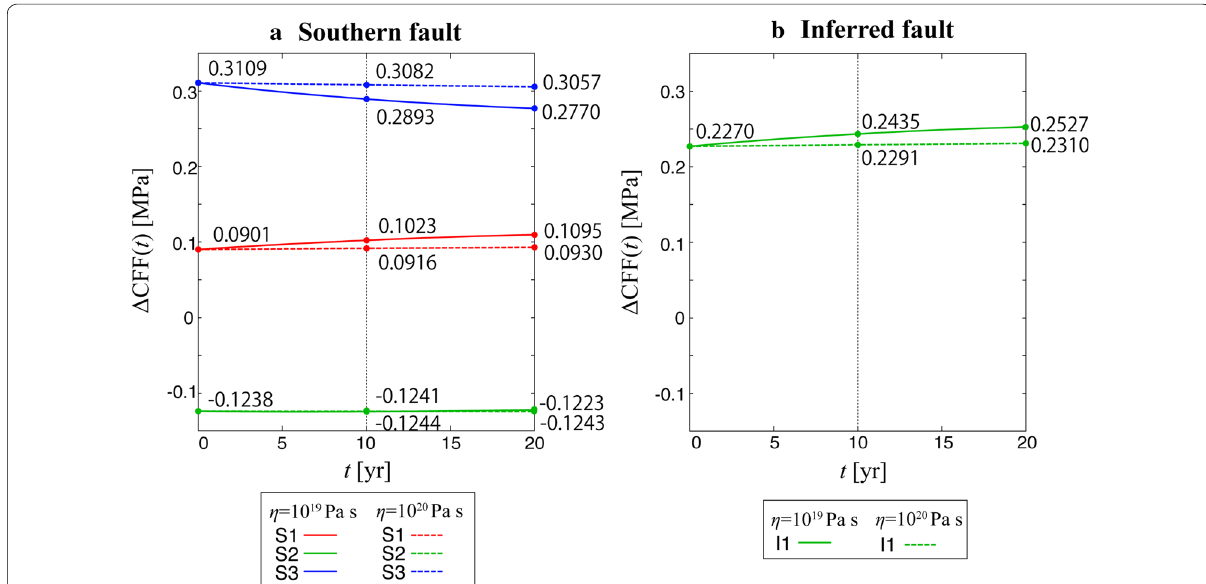
Fig. 7 Time evolution of ΔCFF( t ) at three points along the southern fault (S1–S3 in Fig. 6b) and the point along the SI fault (I1 in Fig. 6c). The solid and dashed lines indicate the cases for η 10 19 Pa s and 10 20 Pa s, =